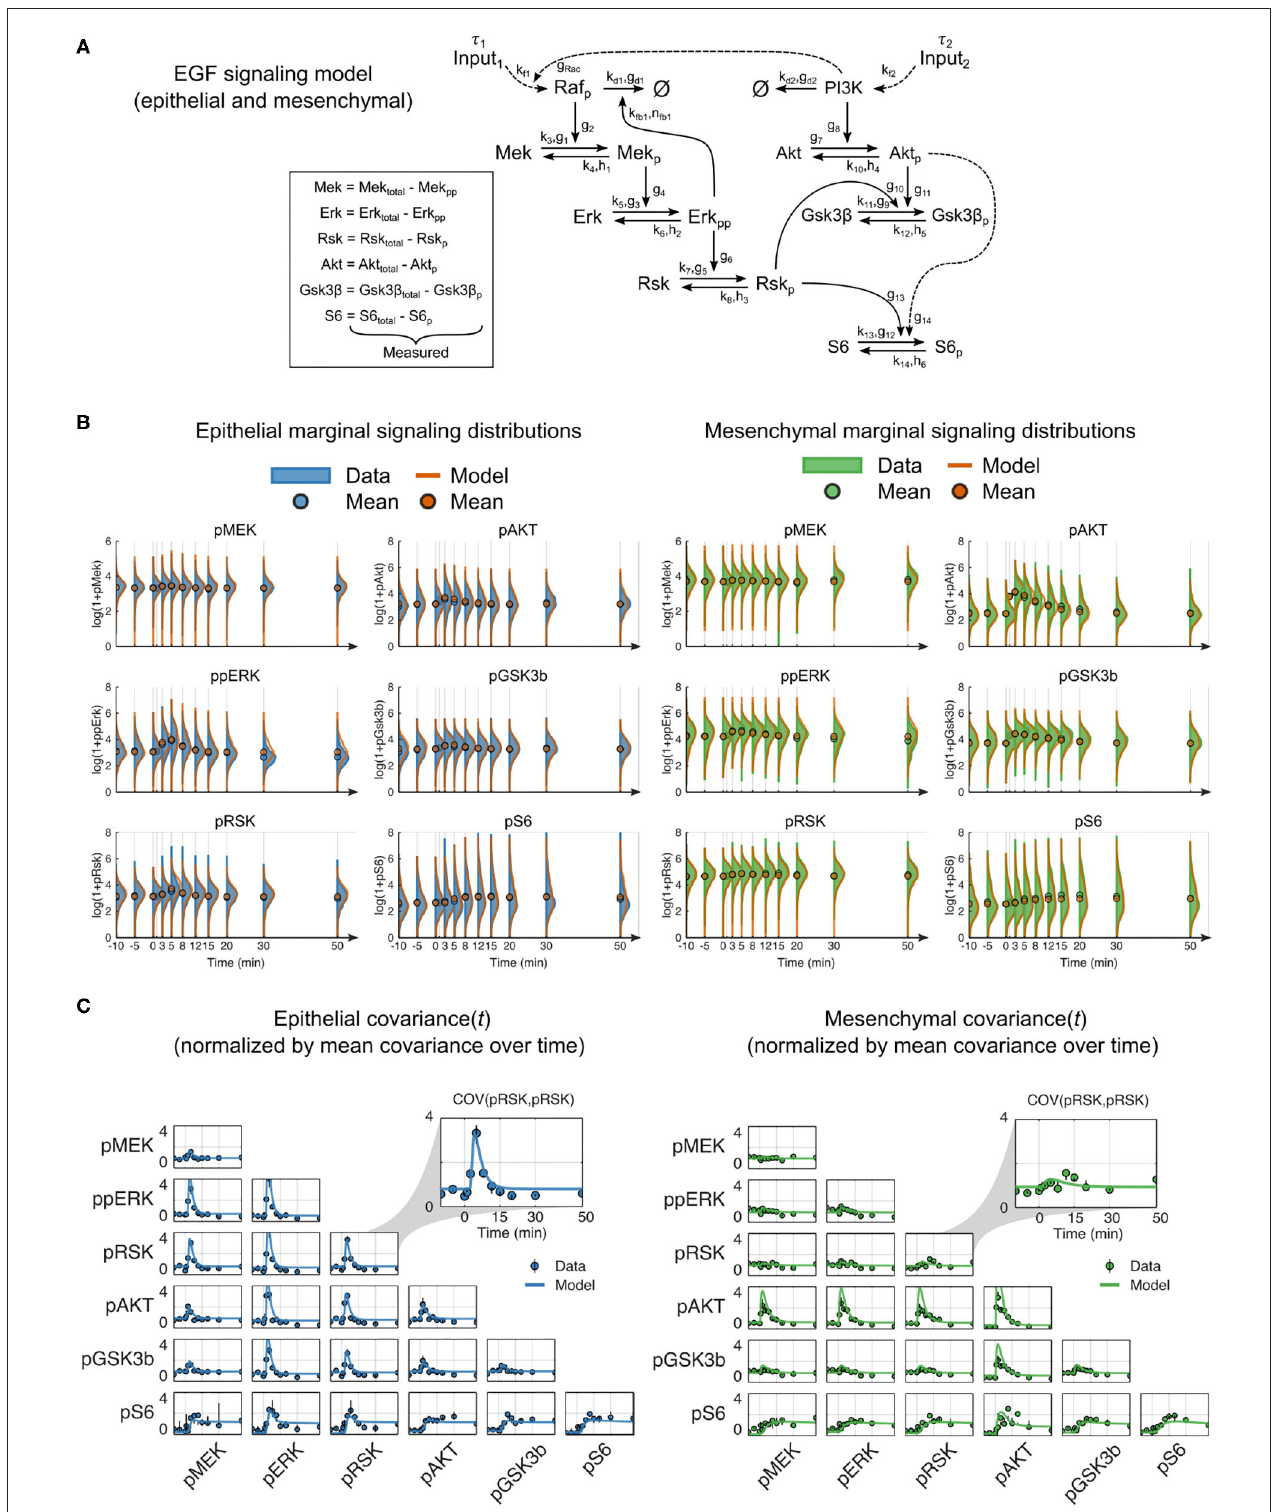
FIGURE 3 | Mechanistic model of EGF signaling in ERK and AKT pathways with parameter fits to epithelial and mesenchymal cells. (A) Model reaction structure and measured variables used for each phenotype annotated with kinetic parameters. (B) Marginal distributions of (log 2 transformed) data (solid) and model simulations